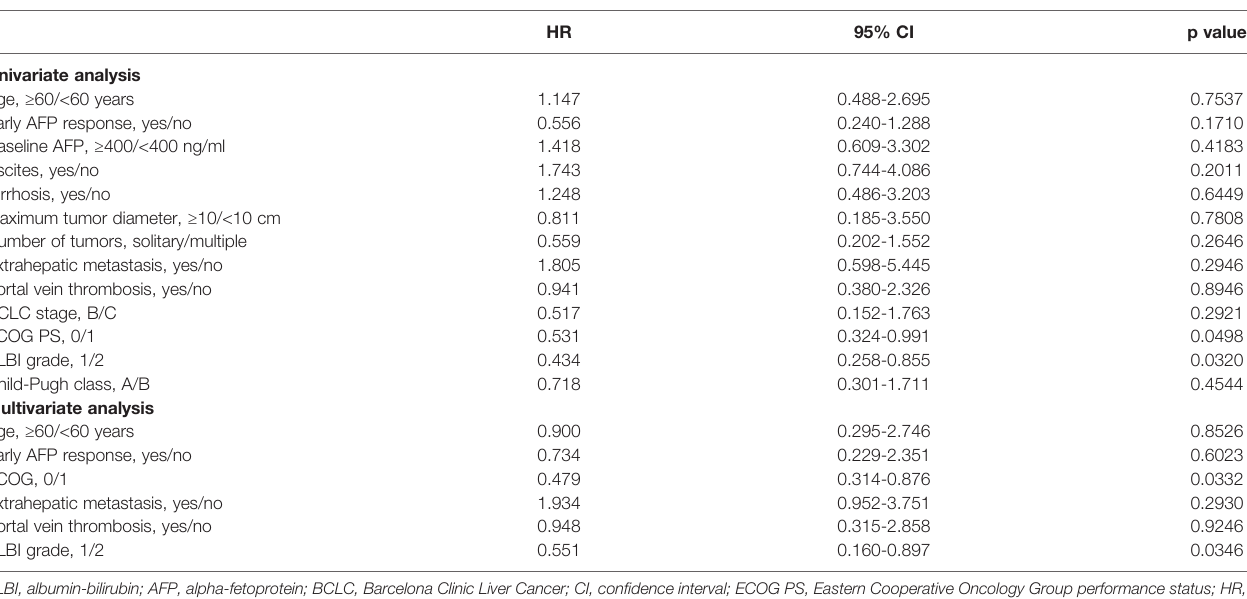
TABLE 4 | Univariate analysis for OS.